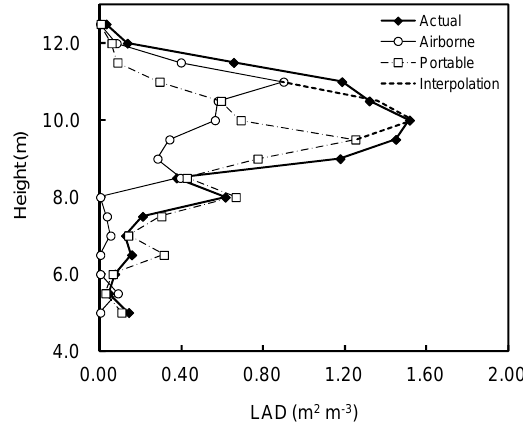
Figure 4: Comparison of LAD profiles for the measurement plot estimated from airborne and portable ground-based lidar measurements and the actual LAD profile (modified form Hosoi et al.,